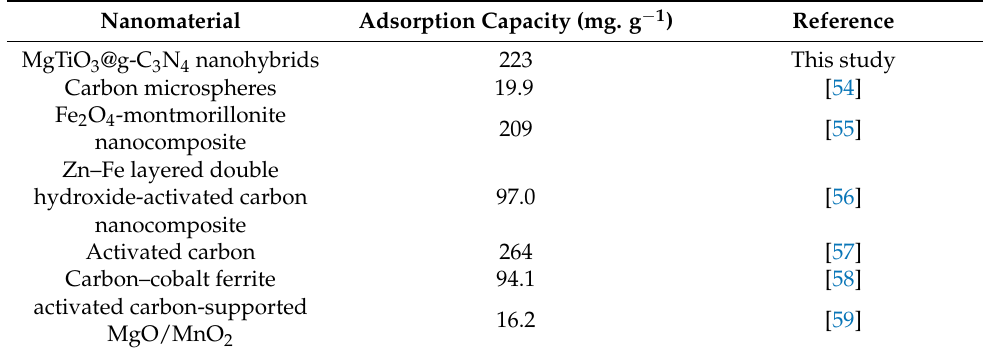
Table 4. Recent literature findings compared to the MgTiO 3 @g-C 3 N 4 fabricated in this study in removing